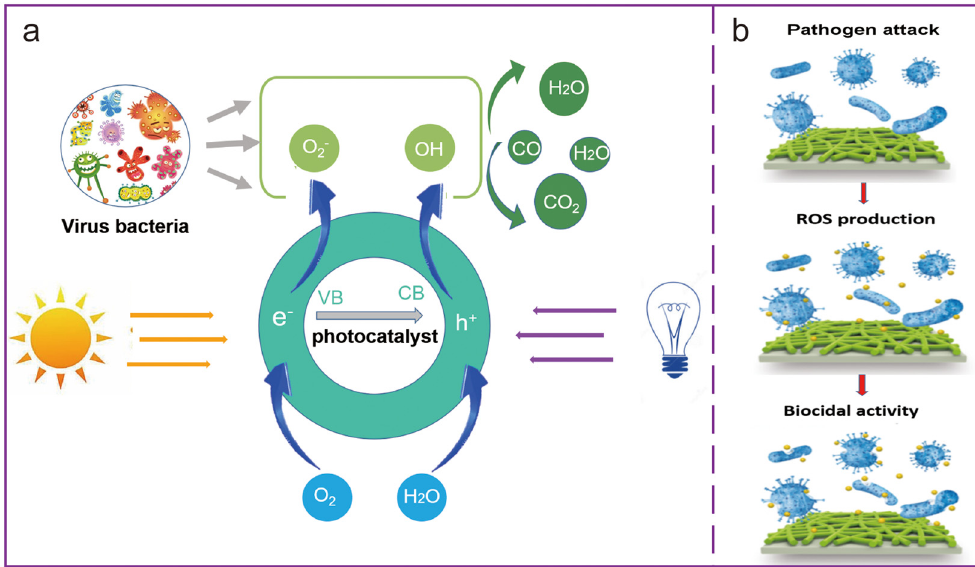
Figure 6: ( a ) Principle of photocatalysis. ( b ) Microbial inactivation process [ 52 ]